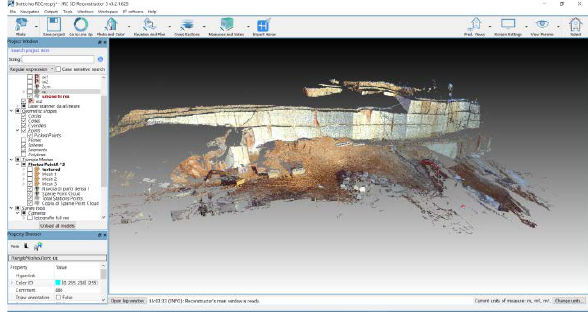
Figure 5. The result of the TLS survey